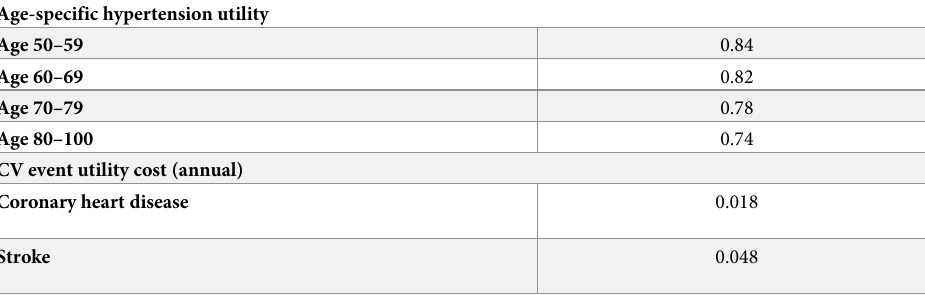
Table 3. Disutility assumptions for age-adjusted hypertension and annual utility costs for CV events. CV =